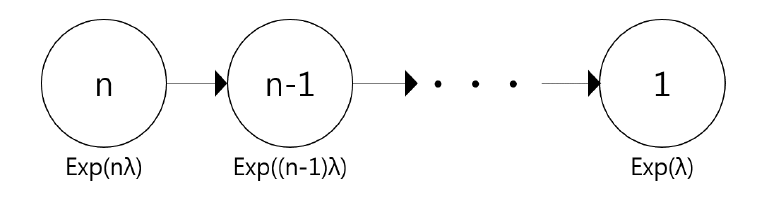
Figure 6. The lifetime distribution of ConClone